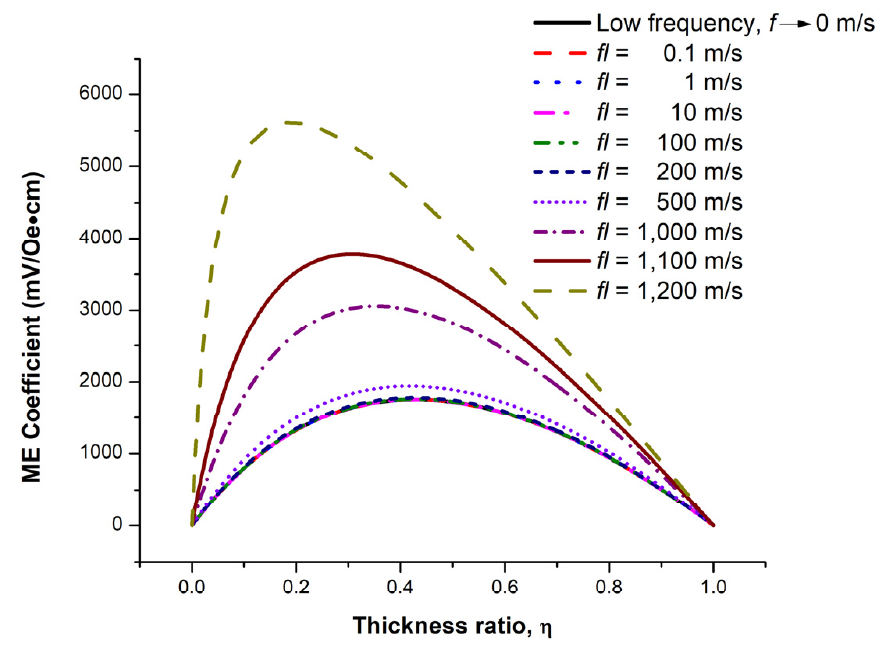
Figure 5. The ME coefficient as a function of thickness ratios for fl = 0.1–1200 m/s [30].